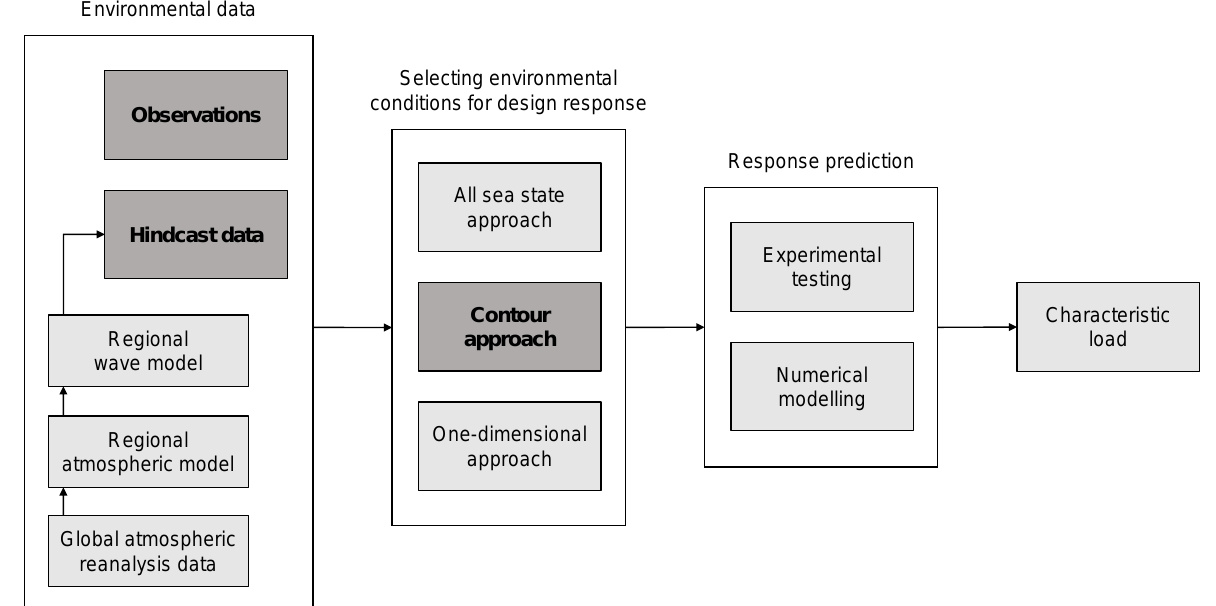
Figure 1. Workflow for determining the characteristic load, with the environmental data as the starting point. The aspects of this workflow that are treated in this paper—observational and hindcast data, and the contour approach—are